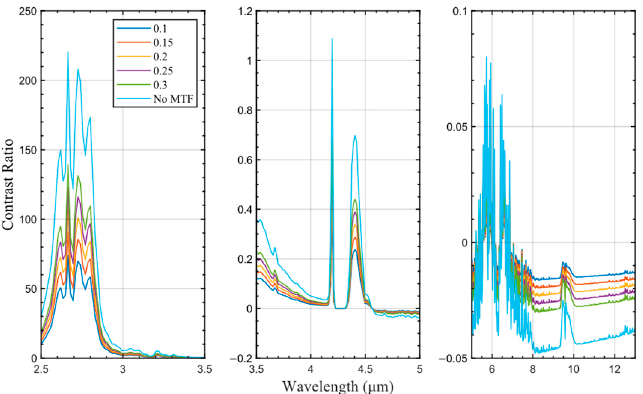
Figure 12. Spectral contrast of target and background at different MTFs of 0.1–0.3.